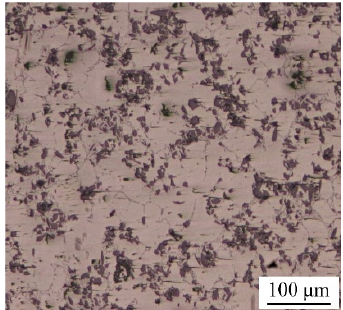
Figure 1. Metallographic structure of 15 vol.% SiC p /6063 Al MMCs manufactured by vacuum stirring casting method.